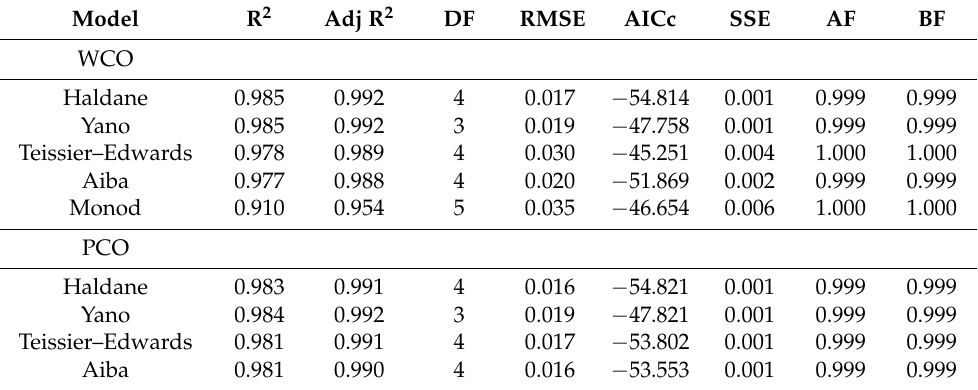
Table 3. Statistical analysis of different standard models applied to WCO and PCO degradation kinetics.